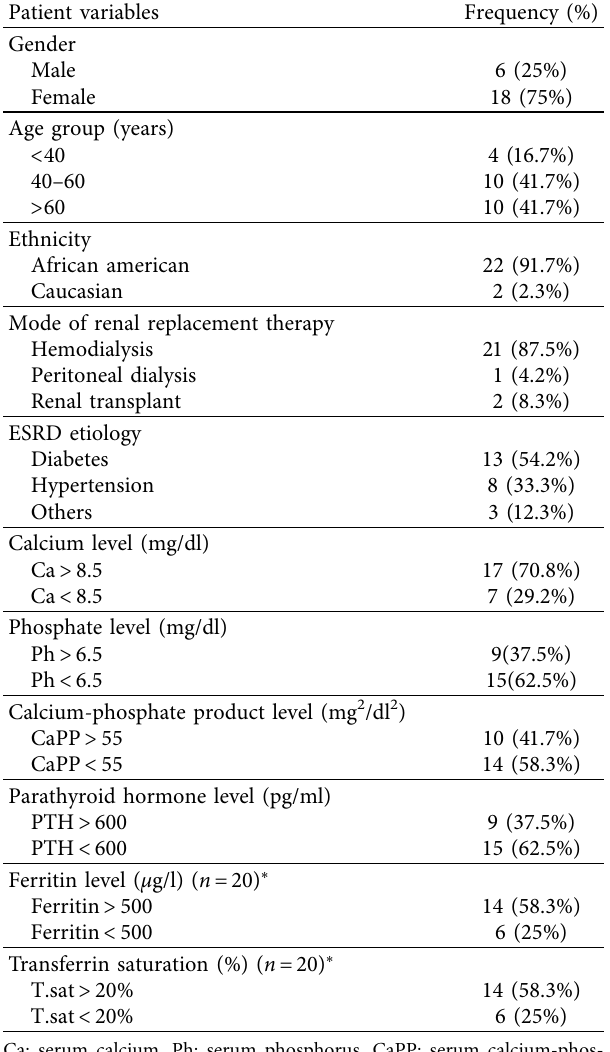
Table 1: Baseline characteristics and biochemical lab values: ( n � 24) unless